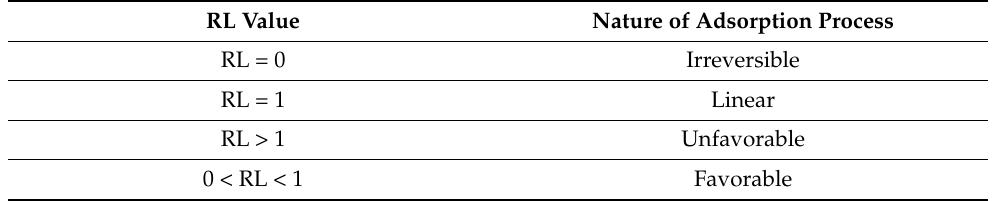
Table 2. Separation